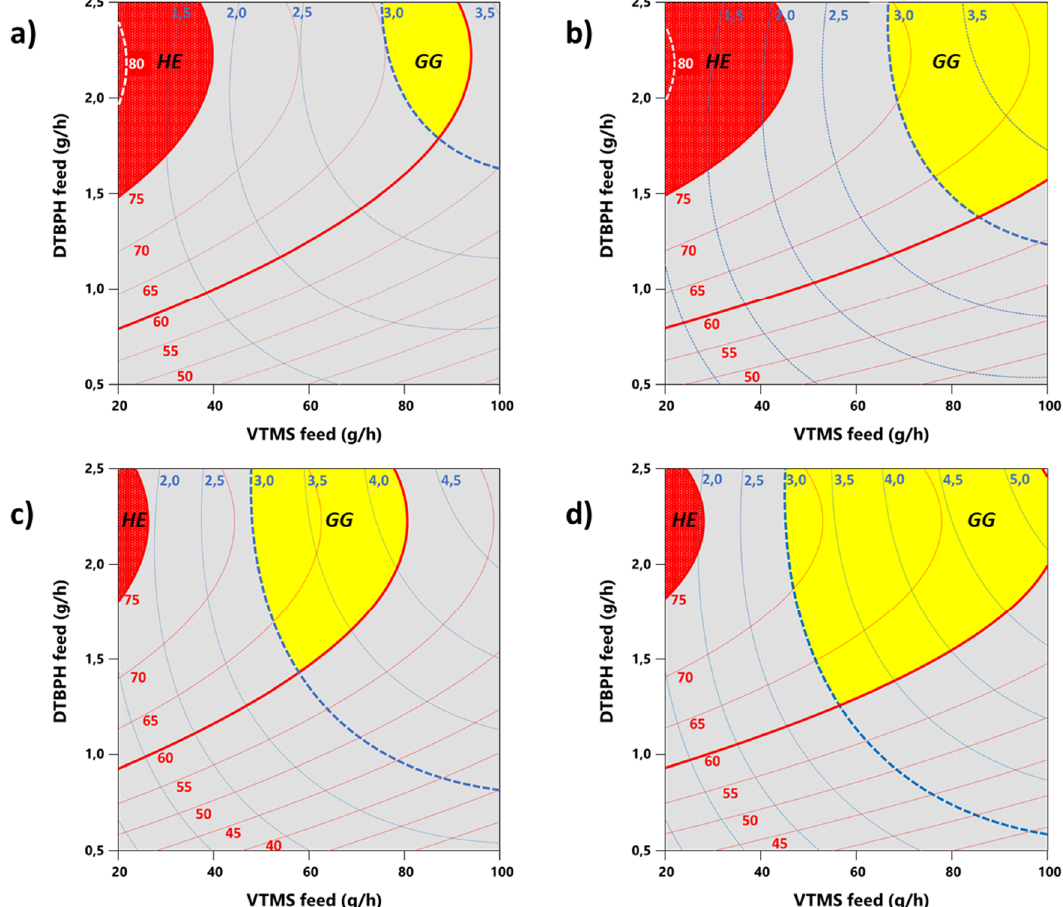
Figure 8. Overlay contour plots illustrating process windows in the design space for various scenarios in the grafting of VTMS onto EOC via reactive extrusion. Process windows for high grafting e ffi ciency (HE regions, indicated in red) and good grafting (GG regions, indicated in yellow) are defined in dependence of grafting degree and grafting e ffi ciency on the VTMS and DTBPH feed rates at ( a ) low-temperature increase and high EC feed rate, ( b ) high-temperature increase and high EOC feed rate, ( c ) low-temperature increase and low EOC feed rate, and ( d ) high-temperature increase and low EOC feed rate. Red dotted lines indicate settings of process parameters that yield the same grafting e ffi ciency. The minimum required grafting e ffi ciency is indicated by the bold red line. Blue dotted thin lines indicate settings of process parameters that yield the same grafting degrees. A minimum grafting degree of 3% is indicated by the bold dotted blue line.